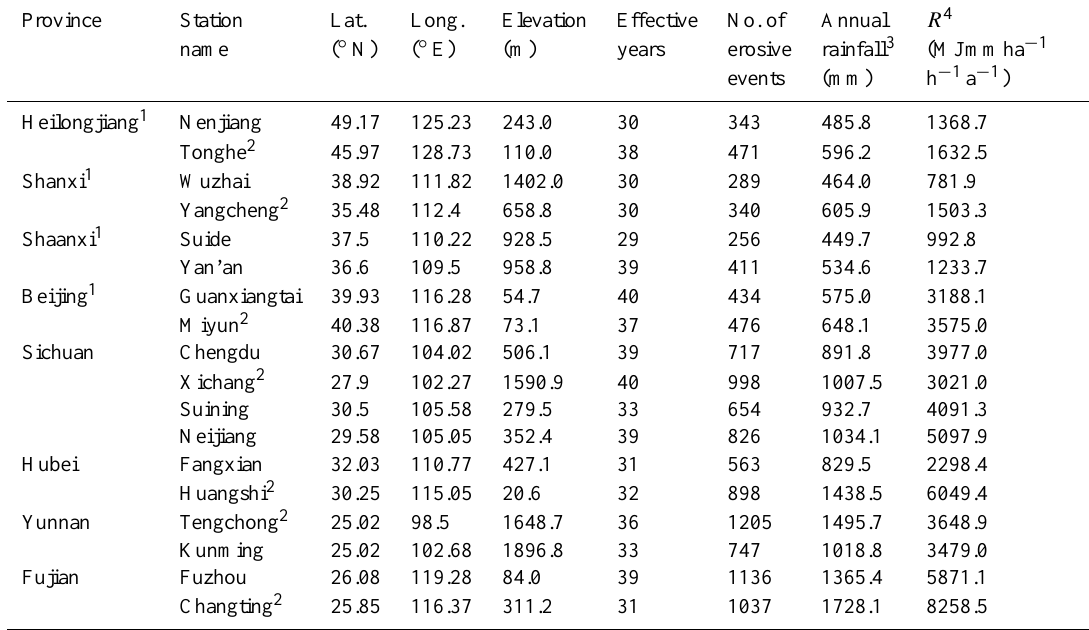
Table 1. Information for the 18 rainfall stations.